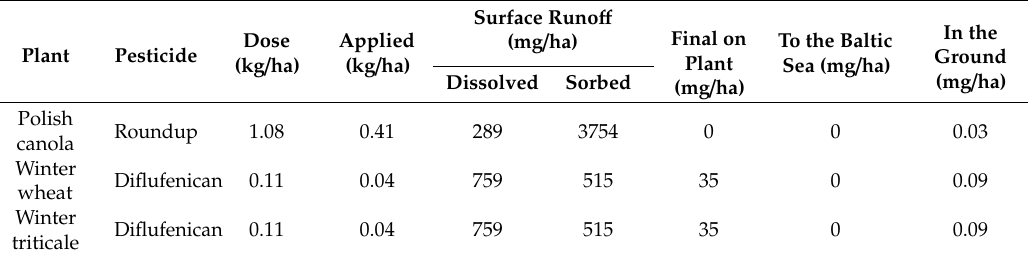
Table 2. Results of pesticide simulations.